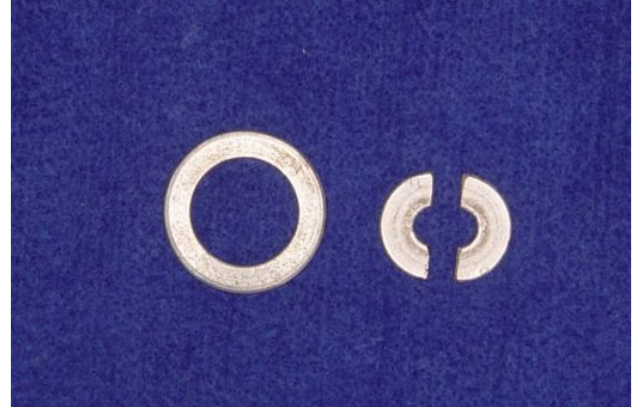
Fig. 1: Circular split-ring metal